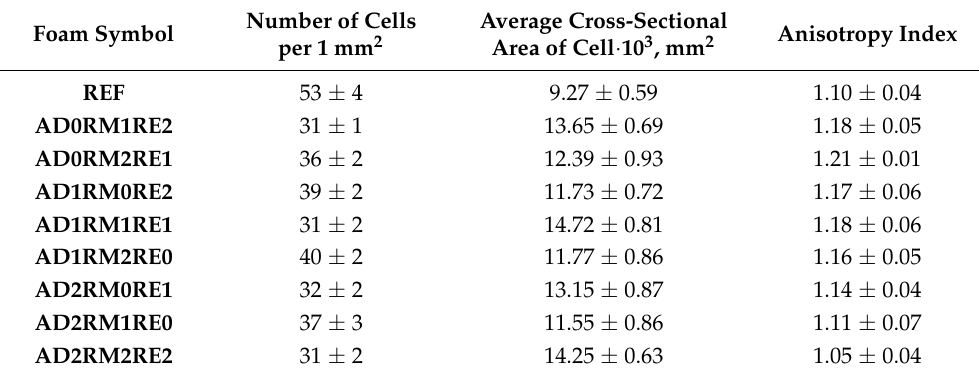
Table 1. Parameters of the cellular structure of rigid polyurethane foams in the cross-section parallel to the foam rise direction.